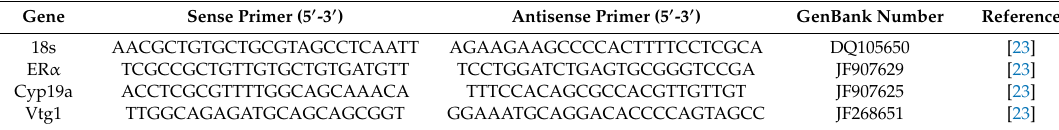
Table 1. Primers for quantitative real-time PCR in marine medaka.